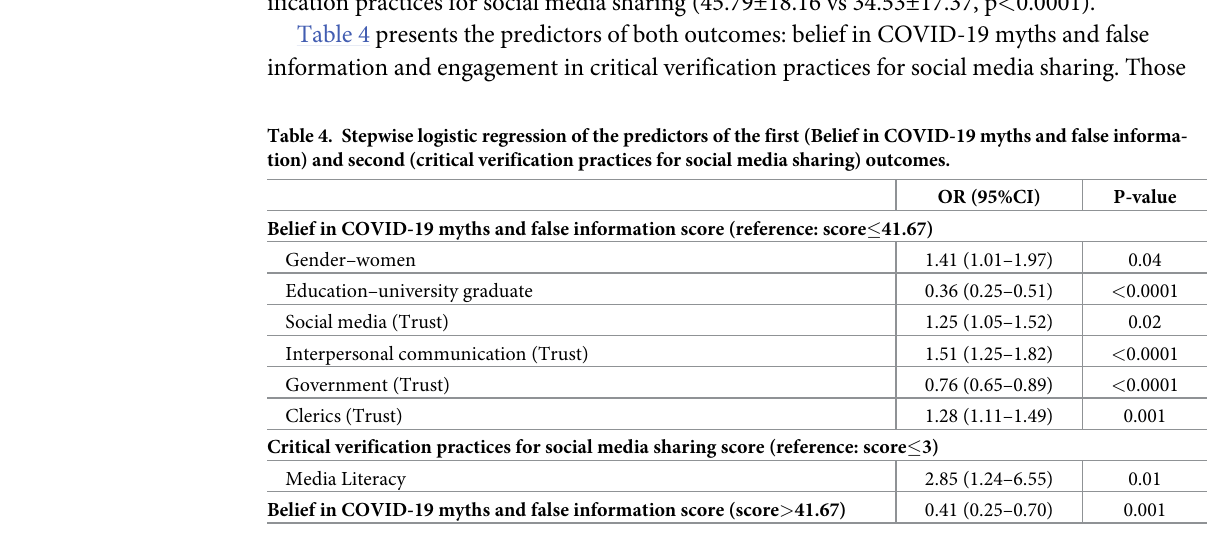
Variables included in the model: gender (reference: men), age (reference: < 30), education (reference: < university), media literacy, Television, social media, interpersonal communication (trust and exposure), healthcare experts, government, clerics, myths and false information (reference: score � 41.67 (median)) adjusted for critical practices